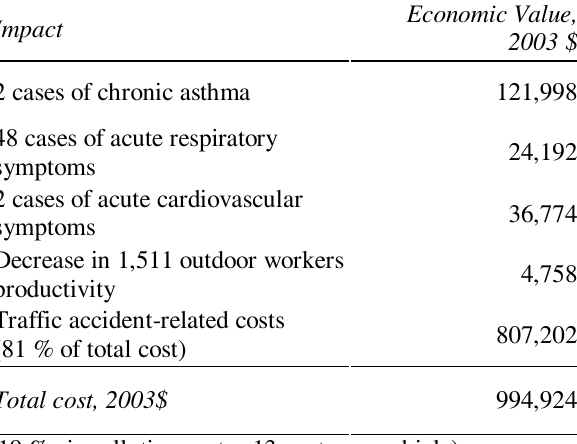
Table 2: Societal costs from increased traffic and air pollution related to accident and public health